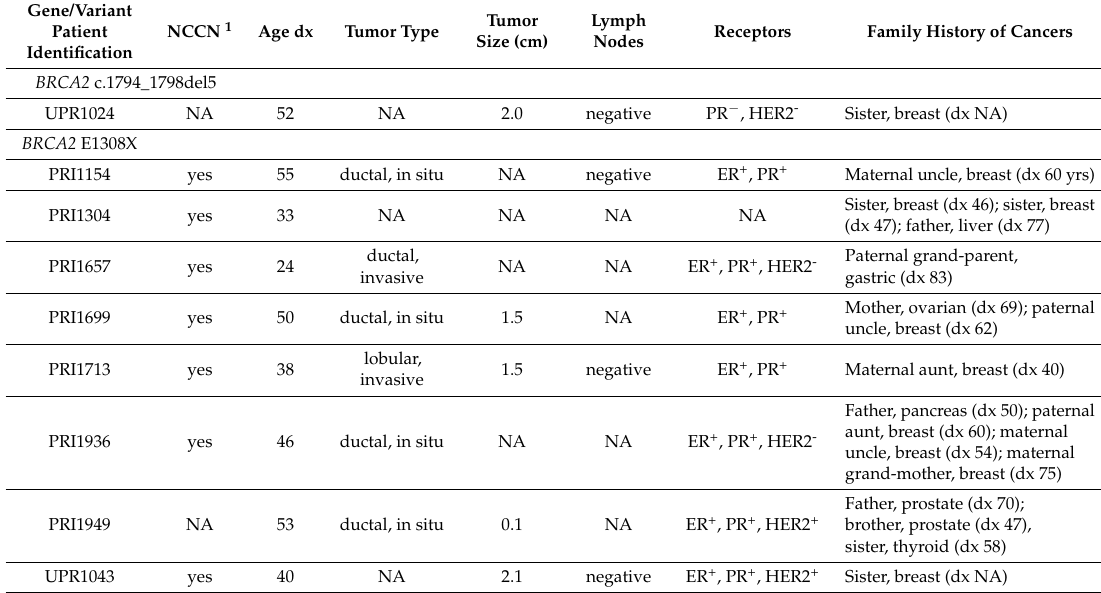
Table 4. Tumor pathology and family history characteristics of the deleterious BRCA variant